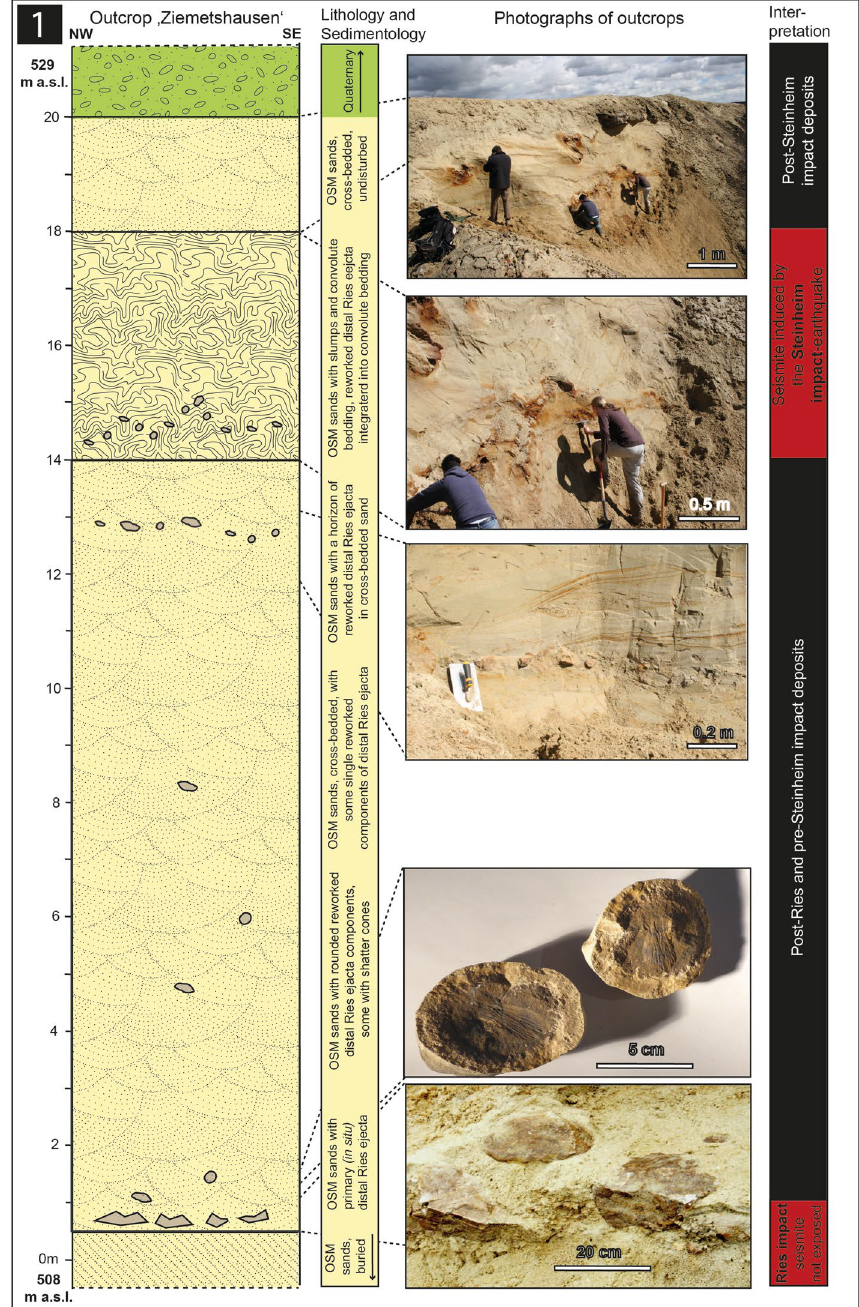
Figure 2. Schematic description of the sedimentological situation (left), outcrop photographs, and event stratigraphic interpretion of the sedimentologic succession (right) in the (former) sand pit Ziemetshausen; outcrop no. 1 in the text. Two impact-seismic events (Ries and Steinheim? impact-earthquakes) are reported by the occurrence of a primary horizon of distal Ries ejecta. Due to the mining level in that outcrop, only the top of sediments of the lower seismite horizon with indistinct convolute bedding were observed. A metre-thick seismite horizon underlying the distal Ries ejecta was not detected unequivocally in this sand pit, but is to be expected. The second impact-earthquake (Steinheim impact) induced a relatively thick seismite horizon with slumps and convolute bedding. A succession of about 12 m of undisturbed OSM sediments were deposited between the two impact events. Photographs of the Steinheim seismite (upper three pictures) were taken by E.B. in 2008 and those of the distal Ries ejecta (lower two pictures) by Peter Bockstaller (Schopfheim) in